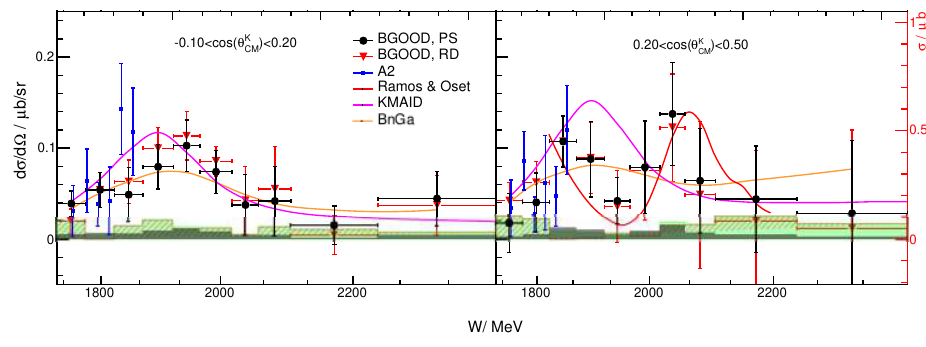
Figure 1. Di ff erential cross section of γ n → K 0 Σ 0 as a function of W for two intervals in cos θ K two di ff erent fi tting methods (red triangles, and black circles). Data from the A2 Collaboration and calculations from KMAID and BnGa are labelled in the legend. The predicted total cross section from Ramos and Oset[7] is included in the angular bin 0 . 2 < cos θ K denoted by the red axis on the right. Figure (adapted) and references in Ref.